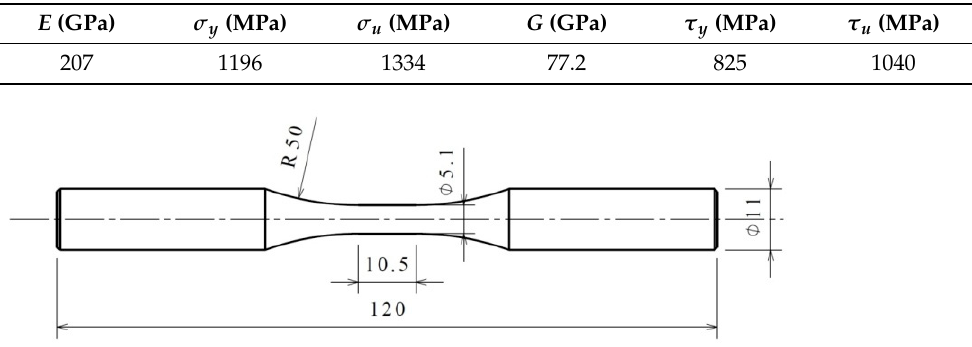
Figure 1. Shape and dimensions of specimens (unit: mm).